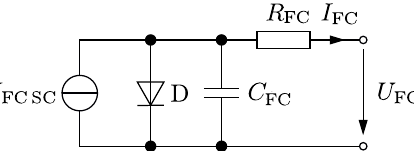
Figure 11. Alternative model of a fuel cell for short circuit current